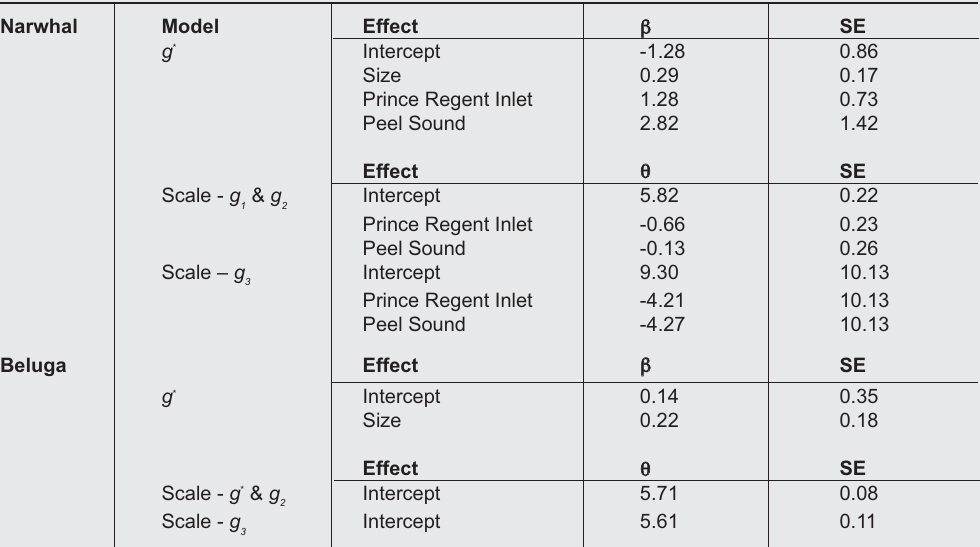
Table 3 . Parameter estimates and standard errors for detection probability models of narwhal and beluga ob- servation data. The parameters are expressed using treatment contrasts for factor ( e.g. regions) variables where the intercept represents the value for the first factor (regions) and the other estimates are differences. For example, is the detection probability at x =0 for narwhal in Peel Sound for a group of 2 whales and for Barrow Strait (the intercept) the same probability is The scale is parameterized in the same manner using a log-link function.